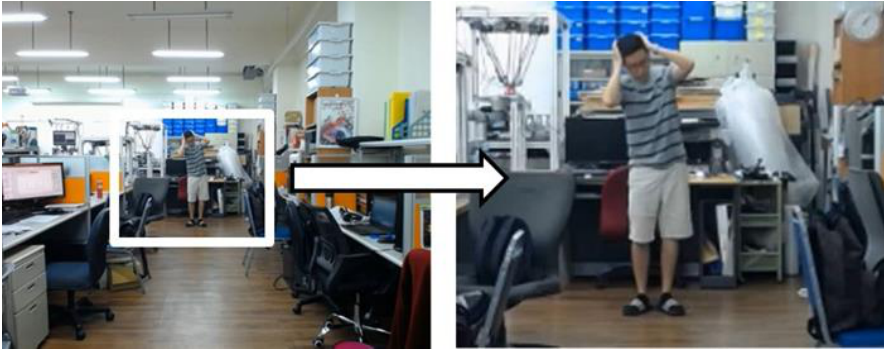
Figure 3. The proposed zoom-in method.